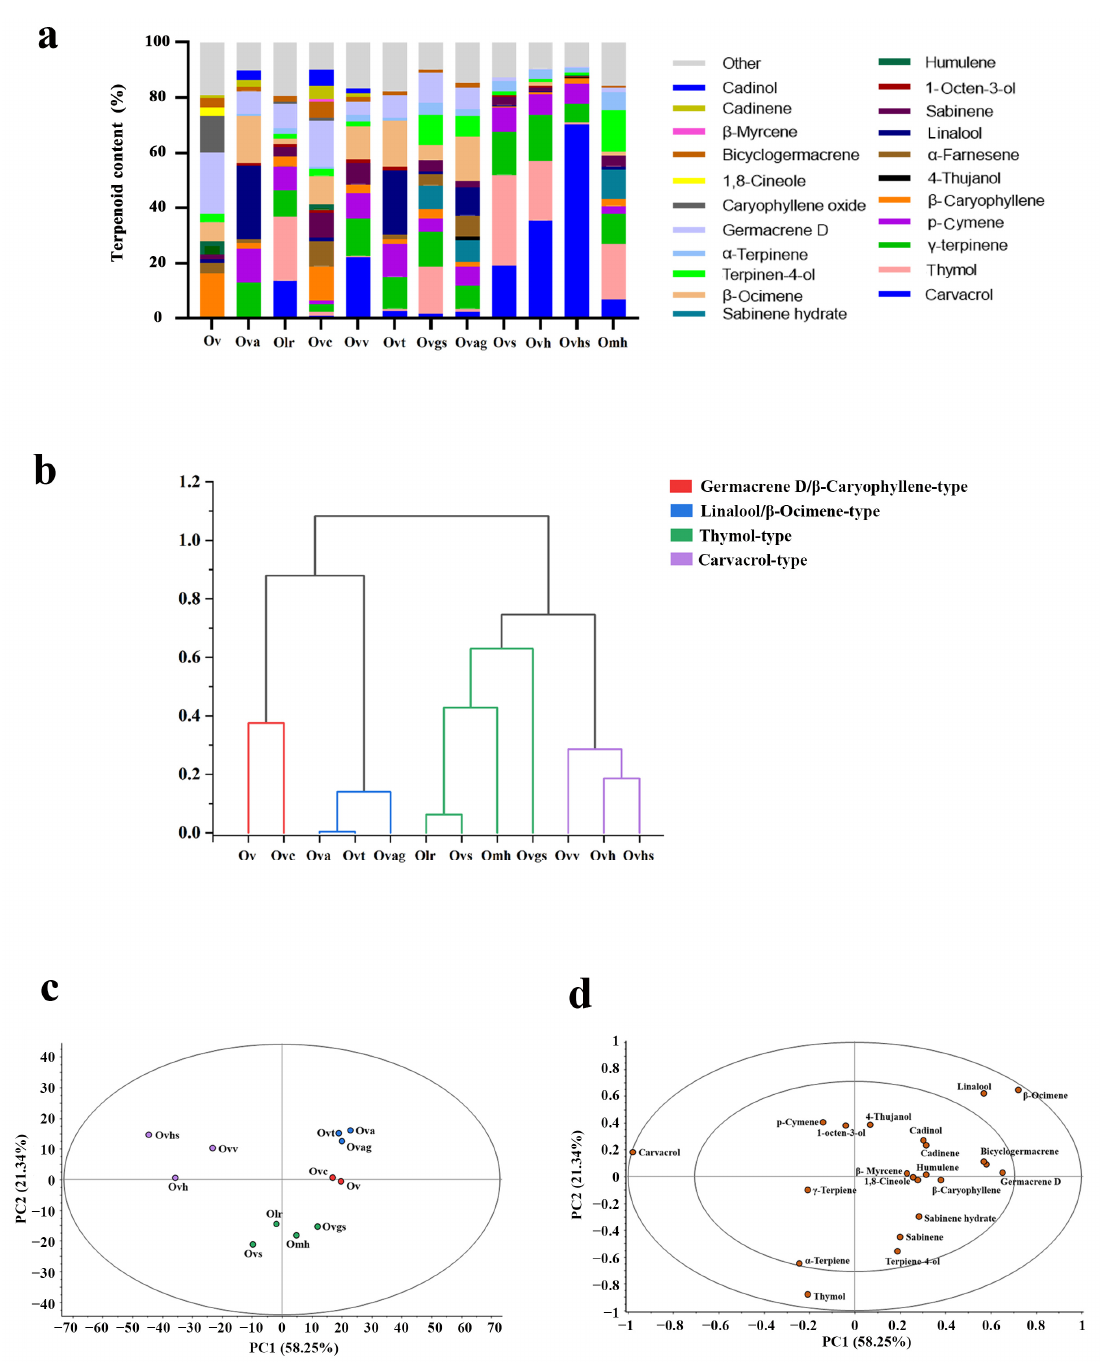
Figure 2. Relative content, cluster analysis, and principal component analysis (PCA) of volatile organic compounds (VOCs) in the essential oils of 12 oregano genotypes. ( a ) Histogram of the relative contents of terpenoids. ( b ) Cluster analysis of 12 oregano genotypes, based on their essential oil compositions. ( c ) Score plot of the tested oregano essential oils. ( d ) Loading plot of active terpenoids. Di ff erent hybrid combinations were designed using male-sterile oregano genotypes (Ovgs, Omh, Ovhs, Ovv, and Ovt) as the female parent and male-fertile oregano geno- types (Ov, Ovc, Ovs, and Ovh) as the male parent. Finally, six hybrid combinations were